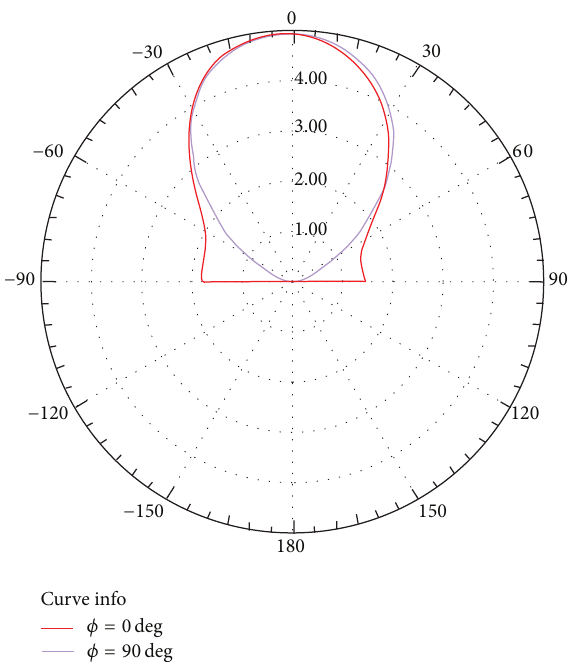
Figure 11: Directivity of the CRA for the first iteration at 3.04